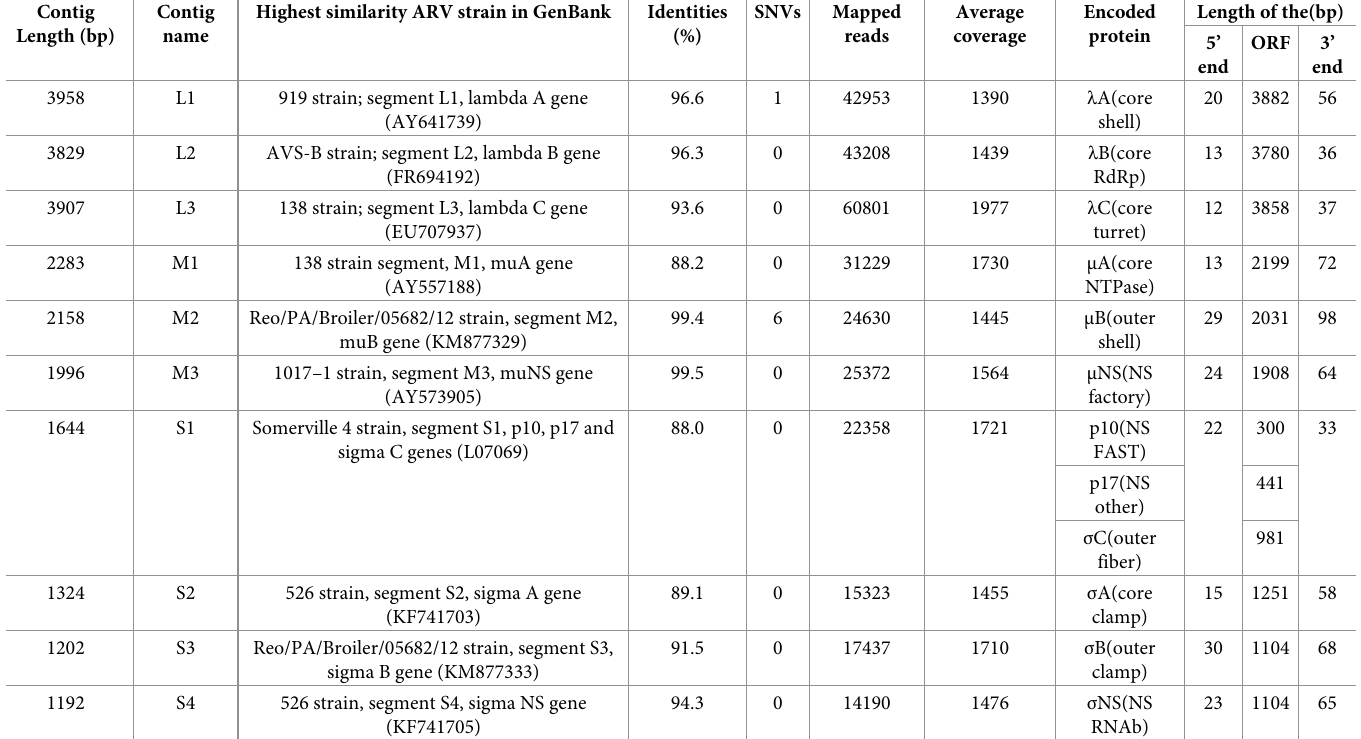
Table 1. General genome features of a pheasant-origin avian orthoreovirus (ARV), the novel field variant of pheasant ARV (Reo/SDWF/Pheasant/17608/20). Contig Length